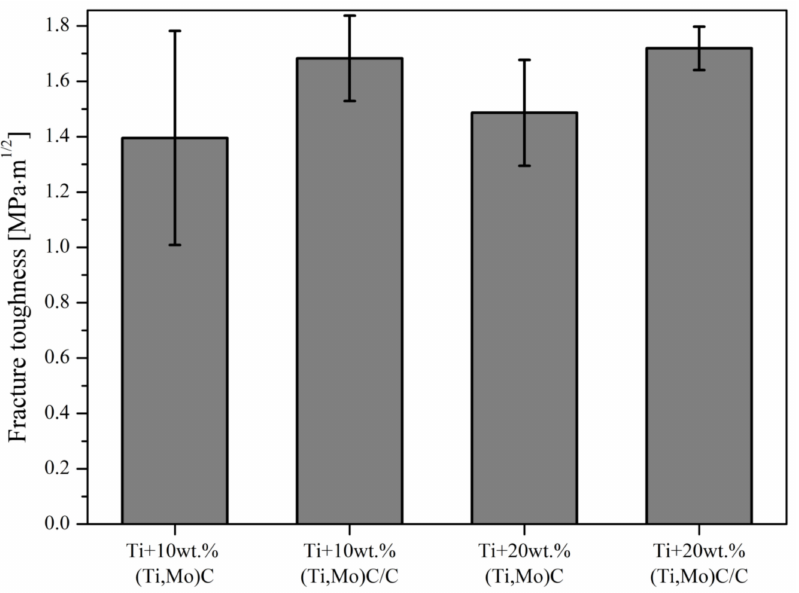
Figure 14. Fracture toughness of the composites with respect to the reinforcing quantity of (Ti,Mo)C and